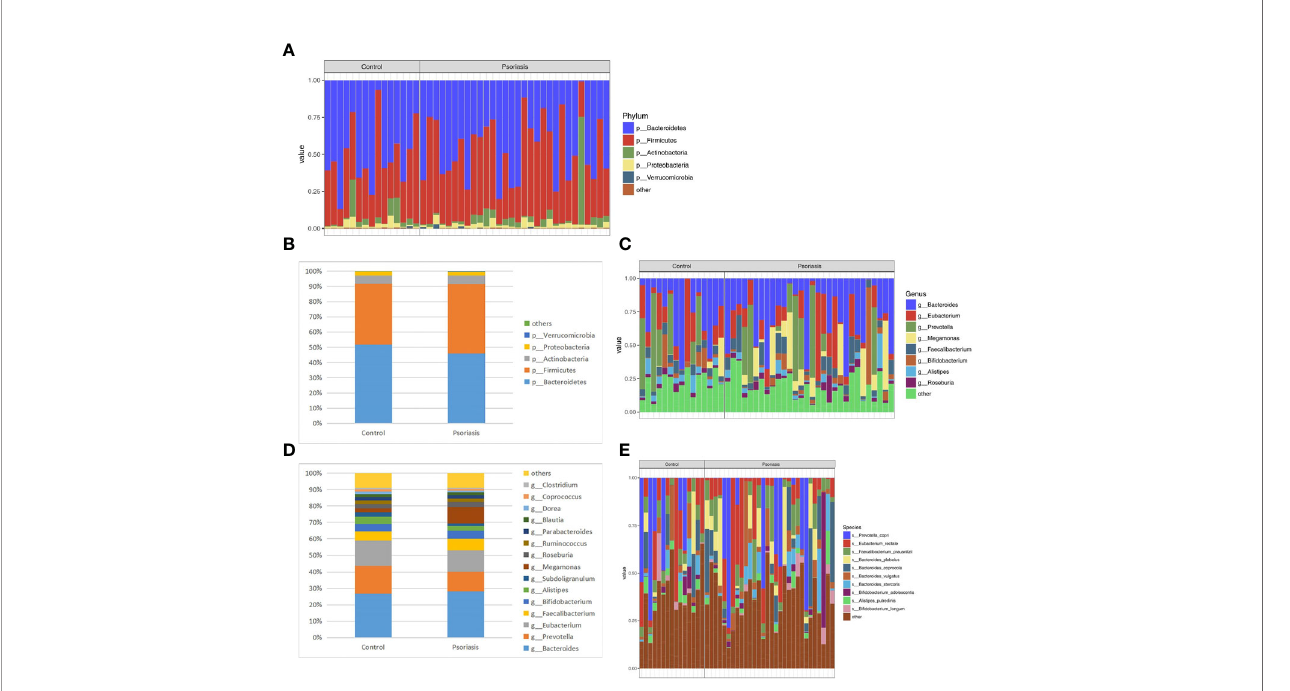
FIGURE 4 | Relative abundance (%) of the intestinal microbiota determined at the phylum (A, B) genus (C, D) and species (E) levels. The columns represent individuals in the psoriasis or control group (A, C, E) .